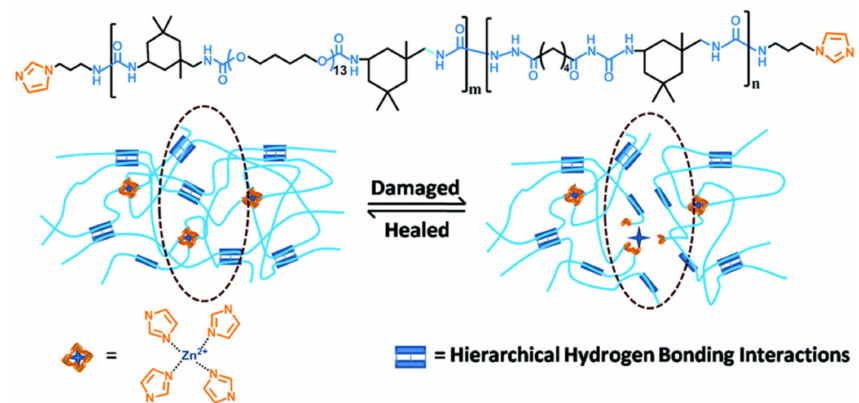
Figure 53. Chemical structure of PU and SHP healing process. Reproduced from [227] with permission from The Royal Society of